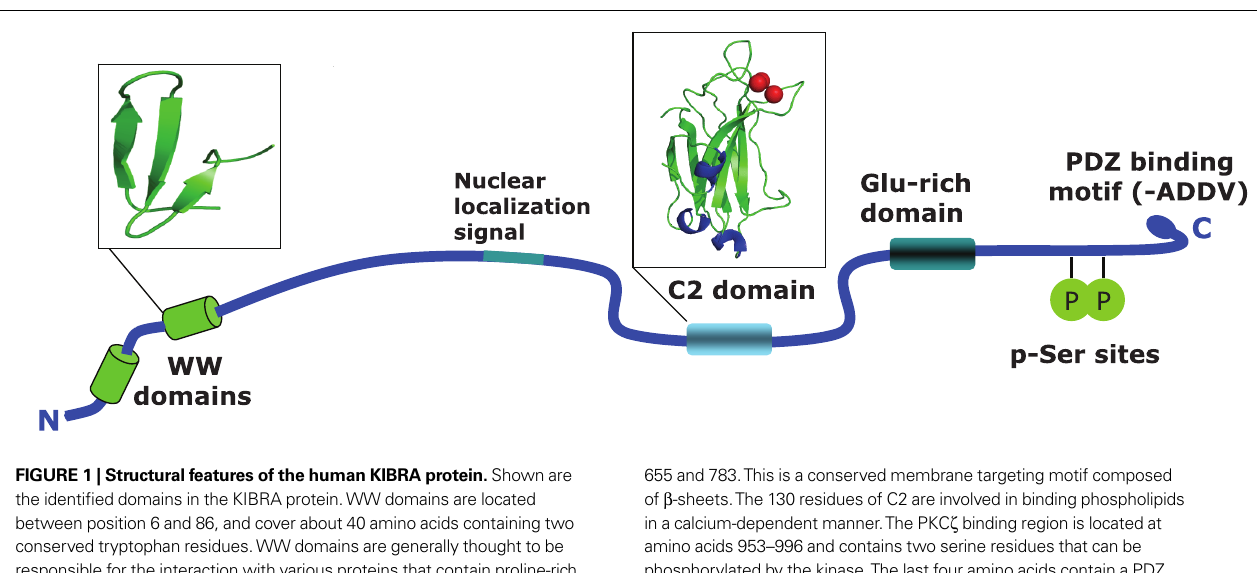
FIGURE 1 | Structural features of the human KIBRA protein. Shown are the identifi ed domains in the KIBRA protein. WW domains are located between position 6 and 86, and cover about 40 amino acids containing two conserved tryptophan residues. WW domains are generally thought to be responsible for the interaction with various proteins that contain proline-rich sequences such as PPxY. The C2 domain is located between amino acids